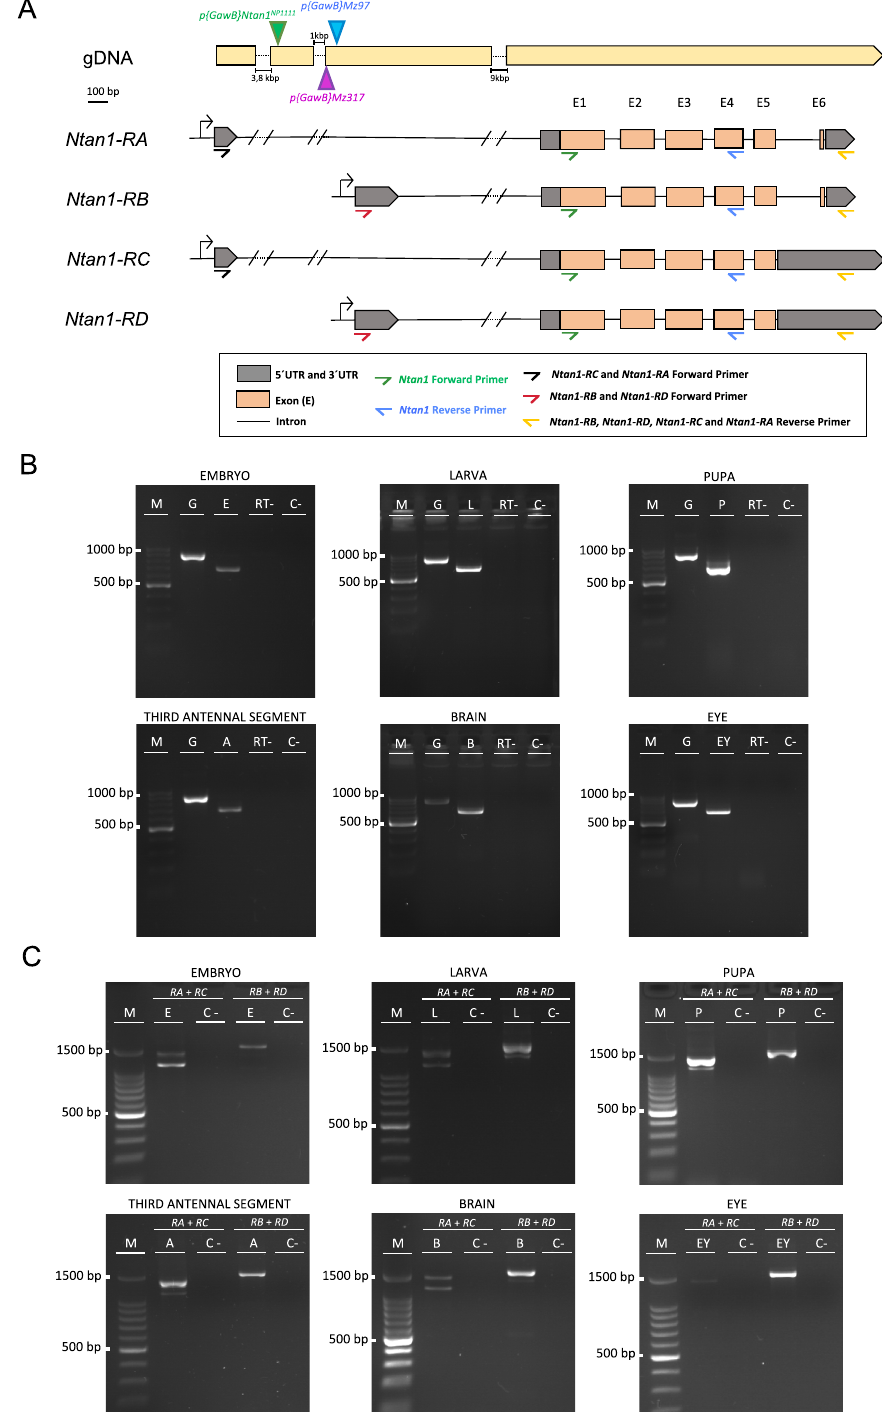
Figure 1. Gene expression analysis of the Ntan1 gene in Drosophila melanogaster . ( A ) Schematic representation of the insertion sites of the Gal4 elements of Mz317-Gal4 ; Mz97-Gal4,UAS-Stinger and Ntan1 NP1111 -Gal4 fly lines in the Ntan1 gene. The P{GawB}Mz317 insertion and the P{GawB}Mz97 are located ∼ 150 bp and ∼ 100 bp upstream of the second transcriptional start site within the first intron, respectively. The P{GawB}Ntan1 NP1111 insertion is located ∼ 1300 bp upstream of the second transcriptional start site within the first intron. 5 ′ UTR and 3 ′ UTR regions, exons and introns of each transcript and the location of the different primers used in RT-PCR are shown. ( B ) Gene expression of the Ntan1 gene by RT-PCR in different developmental stages and adult organs of wildtype flies ( Canton-S ). ( C ) Gene expression of Ntan1 transcripts by RT-PCR in different developmental stages and adult organs of wildtype flies ( Canton-S ). M: Molecular marker, G: Genomic DNA, E : Embryonic cDNA, L: Larval cDNA, P: Pupal cDNA, A: Third antennal segment cDNA, B: Brain cDNA, EY: Eye cDNA, RT−: RT-PCR without retrotranscriptase, C−: Negative